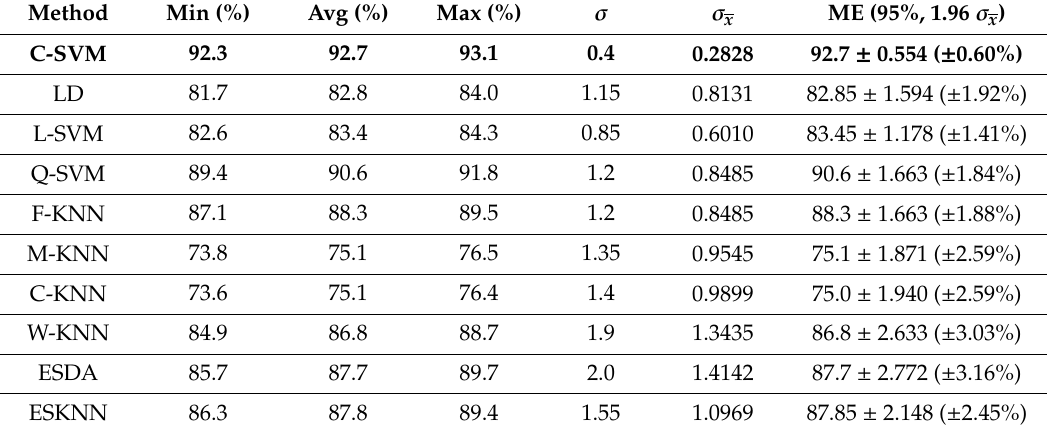
Table 6. Analysis of proposed method on augmented dataset. Best values are shown in